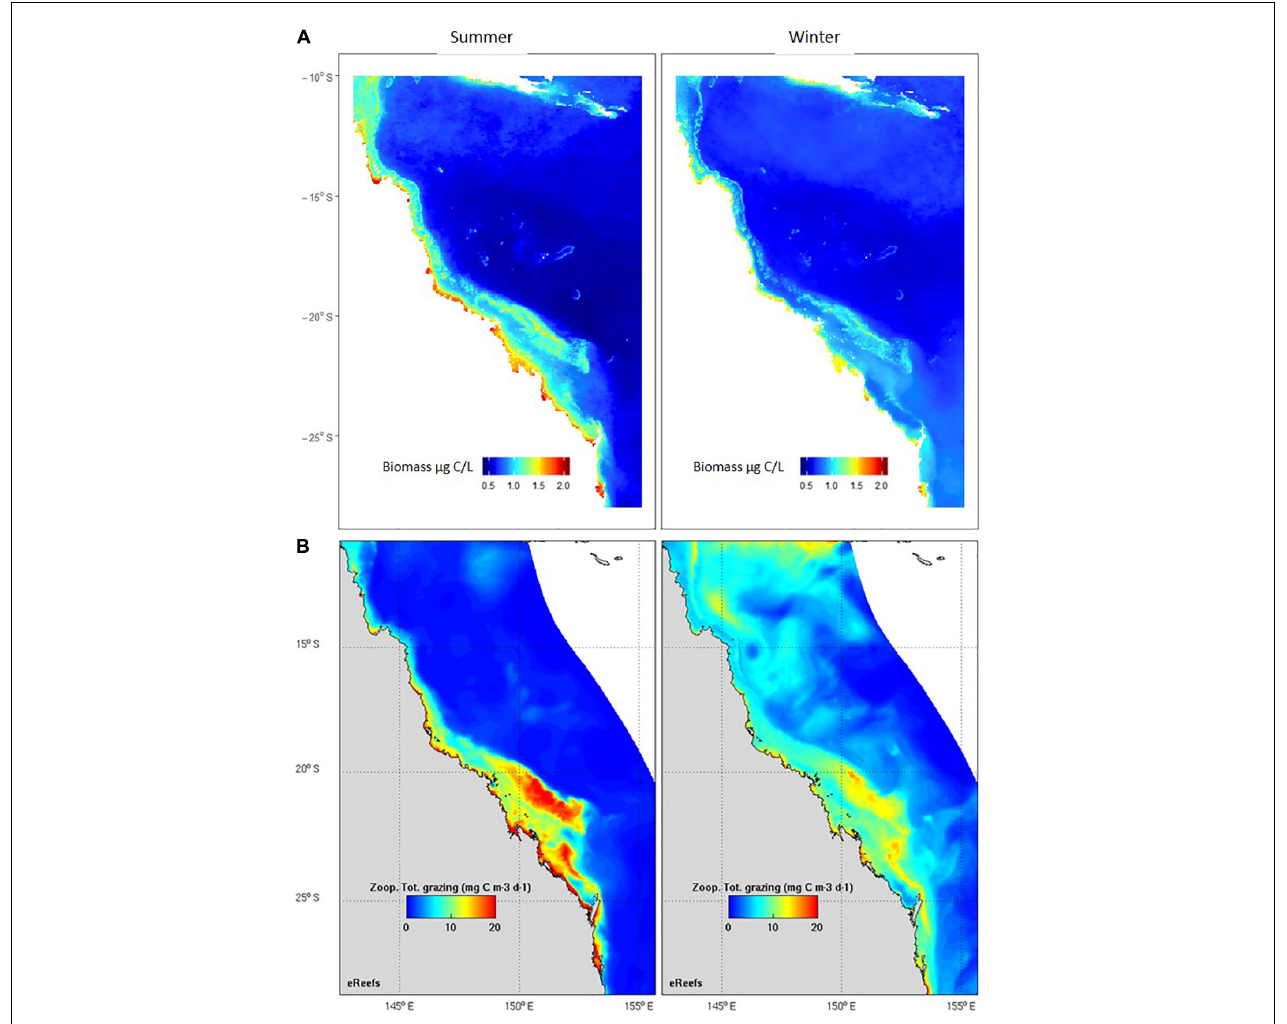
FIGURE 8 | Comparison of seasonal observed and modelled zooplankton. (A) Zooplankton biomass ( µ g C/L) based on > 900 observations, including the IMOS Australian Continuous Plankton Recorder, the IMOS NRS and other zooplankton samples collected within the eReefs domain. Results are from a linear model using data from a statistical model based on mesh size, chlorophyll a , SST, depth and day of year r 2 = 57% (Skerratt et al., 2019). (B) Zooplankton total grazing (mg C/m3/day) output from the eReefs model (Skerratt et al.,